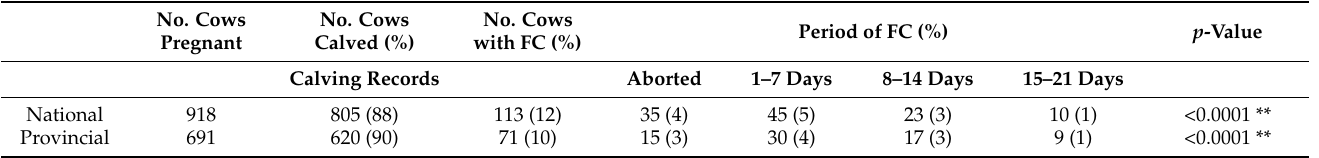
Table 5. Occurrence of fetal and calf losses in beef cattle smallholder herds.